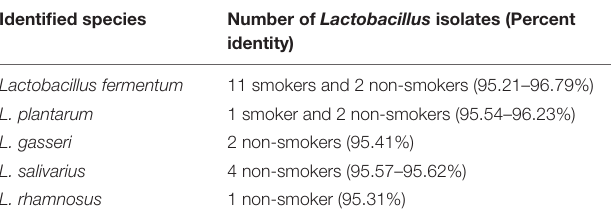
TABLE 2 | Identification of isolated Lactobacillus spp. by 16s rRNA gene sequencing using